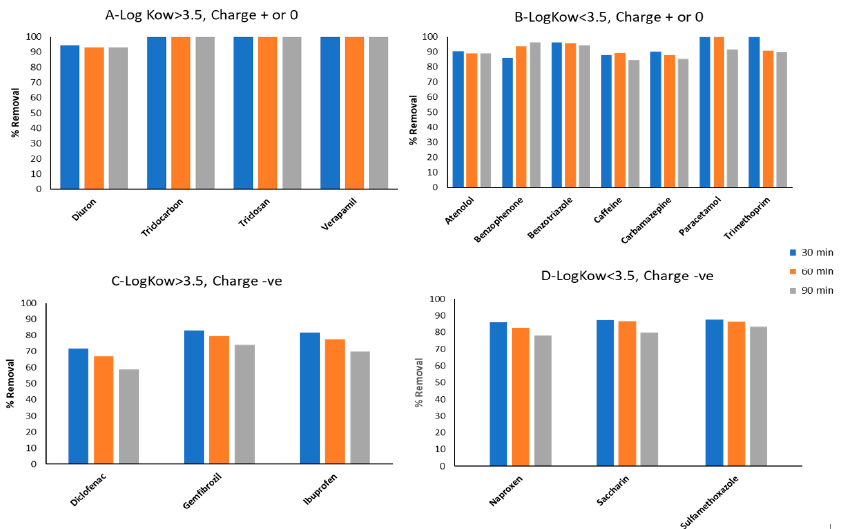
Figure 3. Classification of PPCPs into four groups based on hydrophobicity (Log Kow—higher values indicate greater hydrophobicity) and charge and their removal from ROC collected in a water reclamation plant by GAC columns in a laboratory study after different breakthrough times (modified from Jamil et al. [48]).